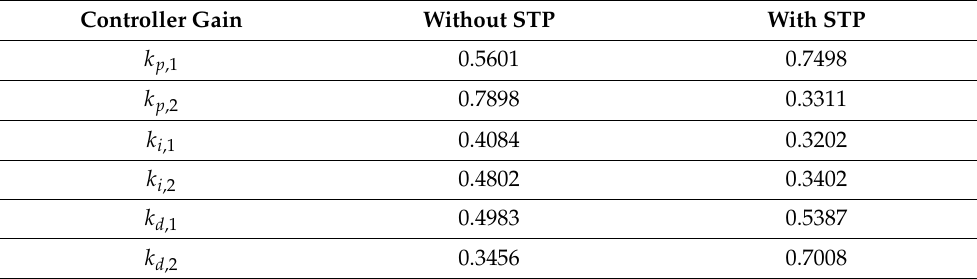
Table 5. Controller gains without and with STP.